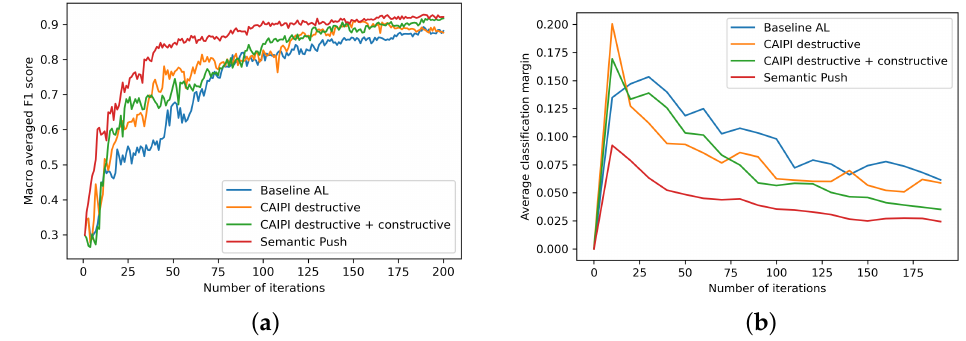
Figure 6. ( a ) Learning performance of different IML strategies for Reuters R10 Dataset (XGBoost as base learner). ( b ) Average Classification Margin of different IML strategies for Reuters R10 Dataset (XGBoost as base